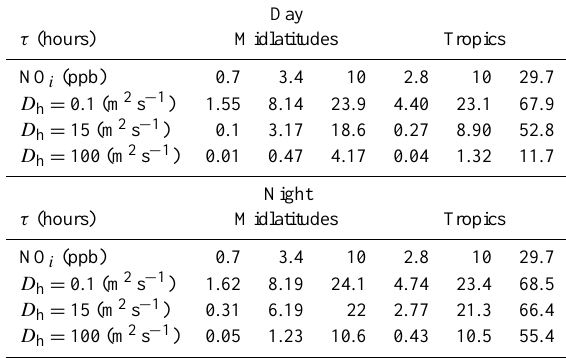
Table 2. The plume lifetime τ (hours) calculated for midlatitudes and tropics depending on the initial NO mixing ratio injected by lightning emissions (NO i , ppb) and the horizontal diffusion coeffi- cient ( D h , m 2 s − 1 ) for day (upper part of table) and night conditions (bottom part of